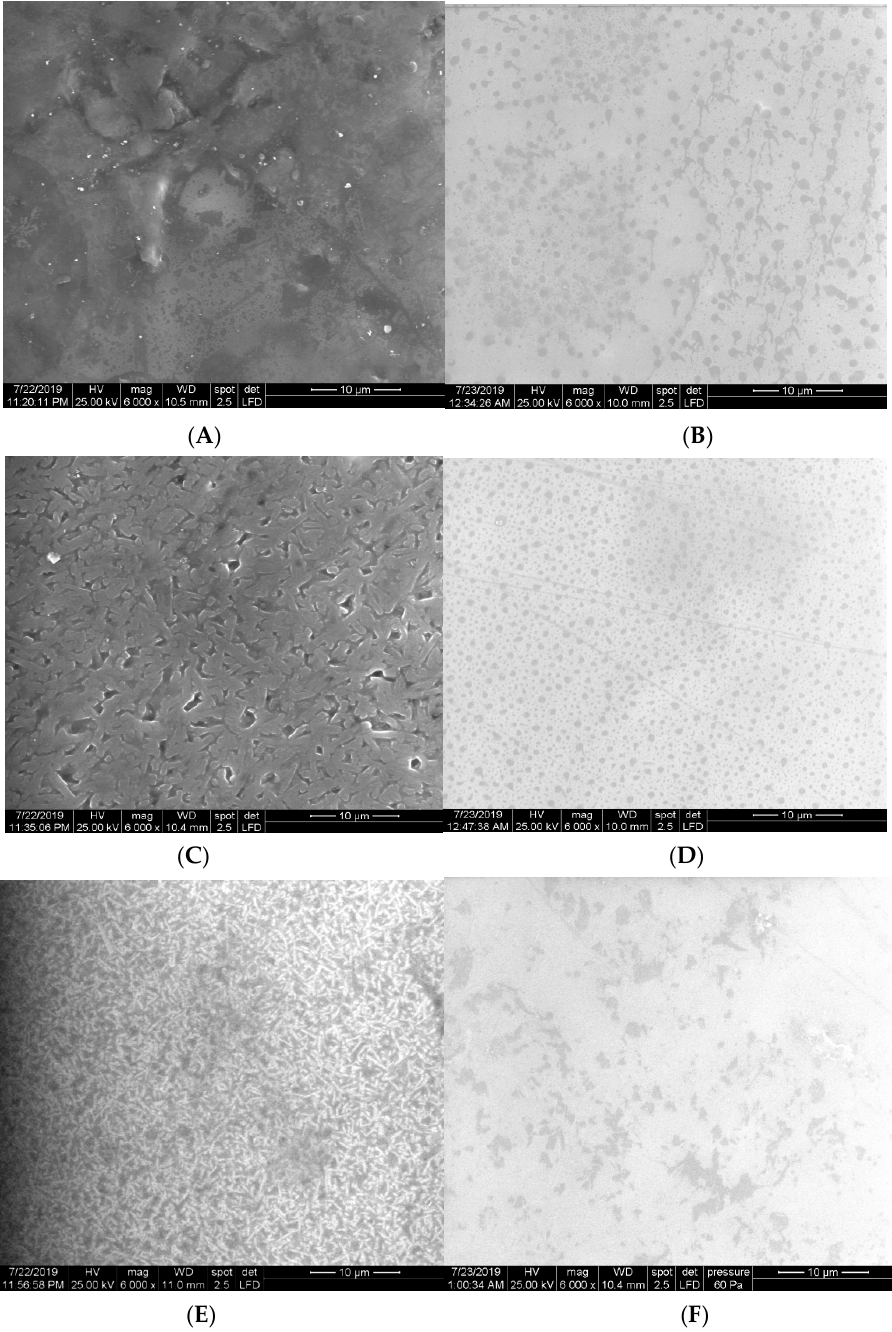
Figure 5. SEM micrographs before thermocycling. ( A ) Vita polished; ( B ) Vita glazed; ( C ) Emax polished; ( D ) Emax glazed; ( E ) Celtra polished; and ( F ) Celtra glazed.